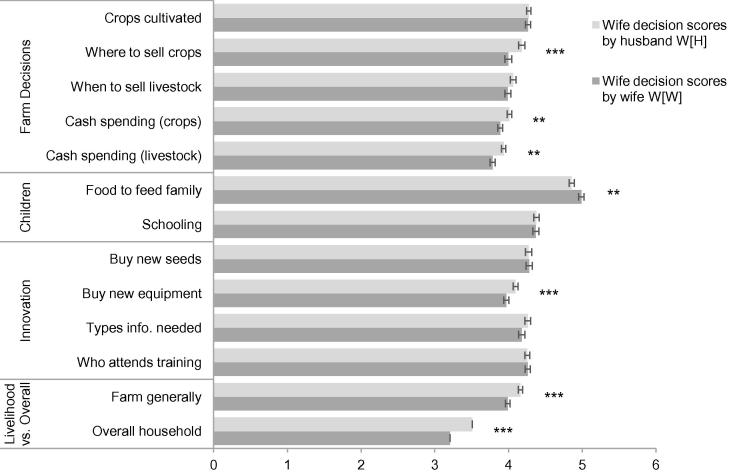
Beans allocated to wives, averages by husbands Wi[Hi] and by wives Wi[Wi] by decision Mean out of 10 beans, with standard errors and significant differences using unpaired t-tests. ∗p < 0.10; ∗∗p < 0.05; ∗∗∗p < 0.01.